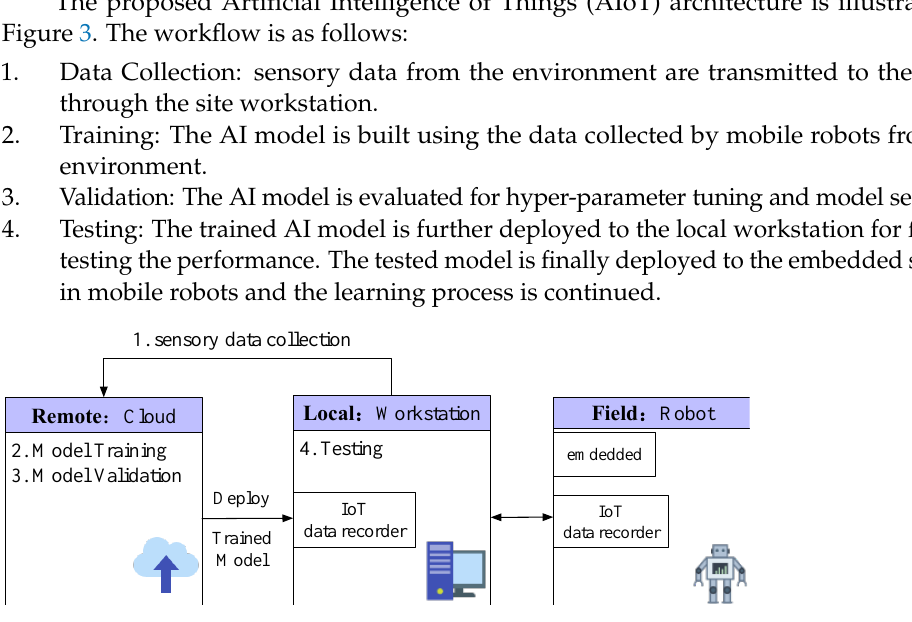
The proposed Artificial Intelligence of Things (AIoT) architecture is illustrated in Figure 3. The workflow is as follows: